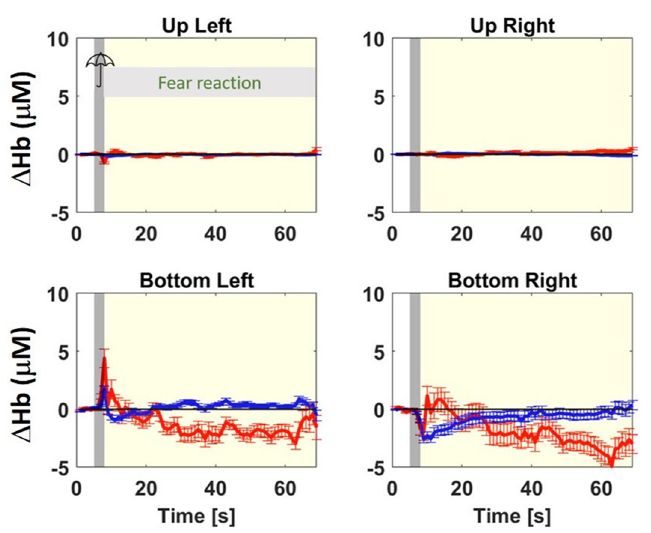
Figure 4. Same as Fig. 2 but group-average of the stand group (sheep were still during and after the 3 s startling